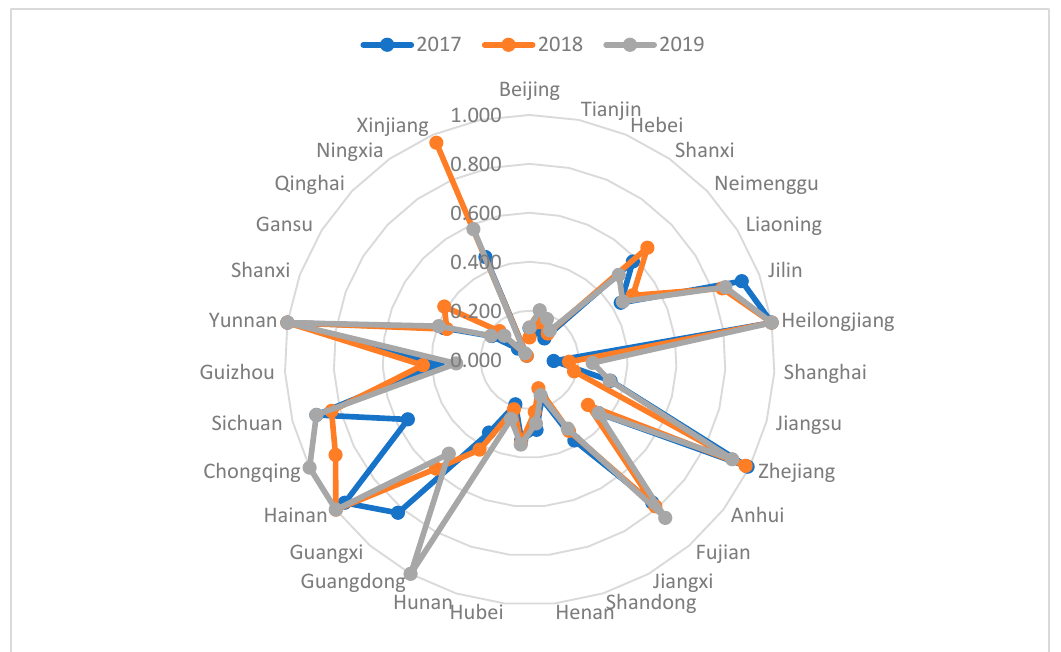
Figure 2. Integrated efficiency value of forest carbon sink in China, 2017–204. Table 2. Distribution of forest carbon sink efficiency in China,